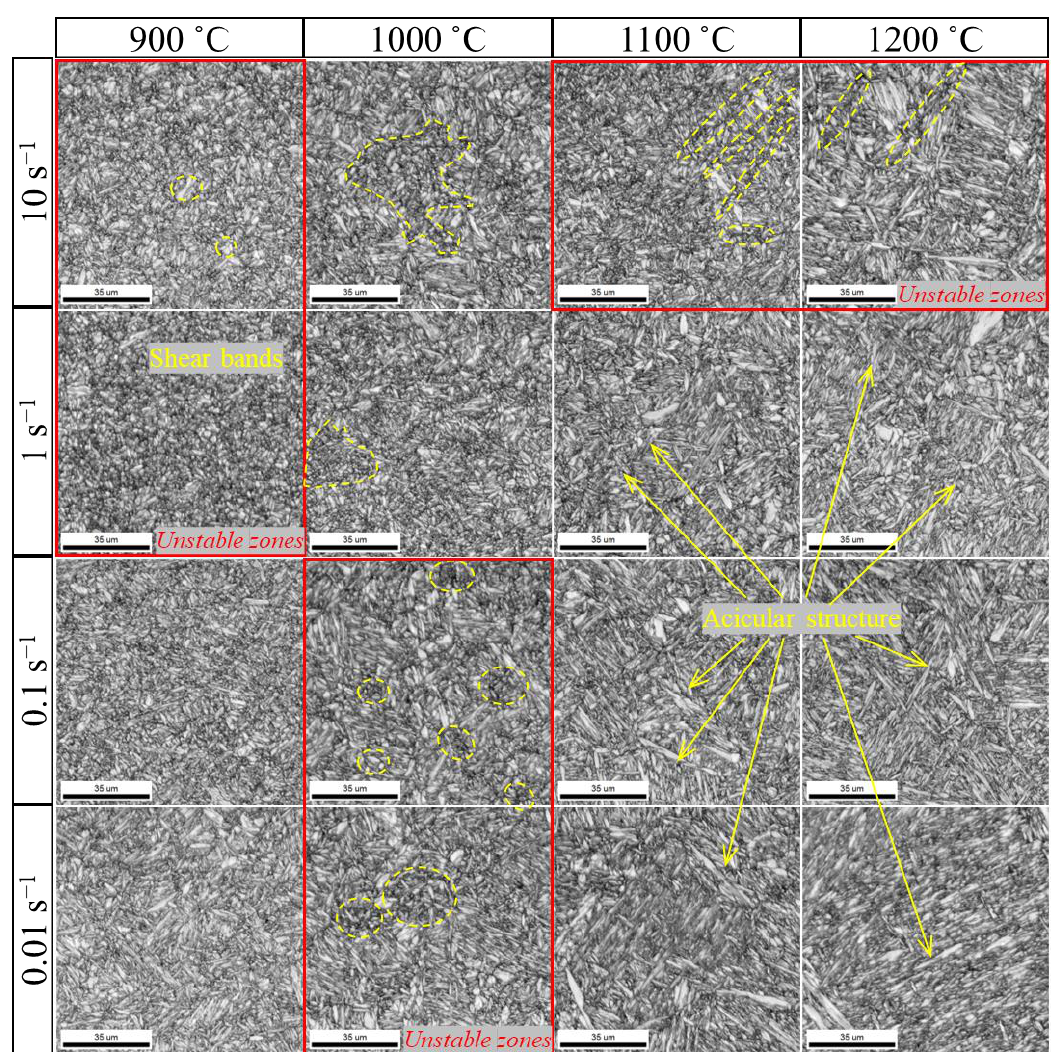
Figure 15. The image quality map of the specimen compressed at different conditions.